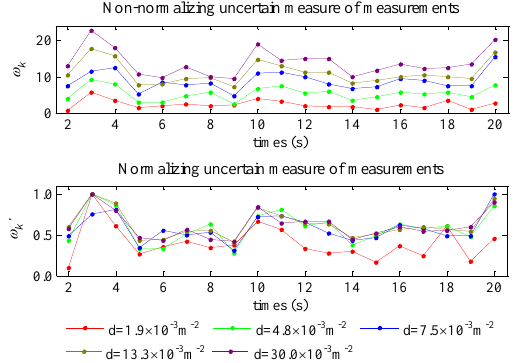
Information 2018 , 9 , x FOR PEER REVIEW Figure 3. Variation curves of uncertain measures of measurements. Figure 3. Variation curves of uncertain measures of measurements.